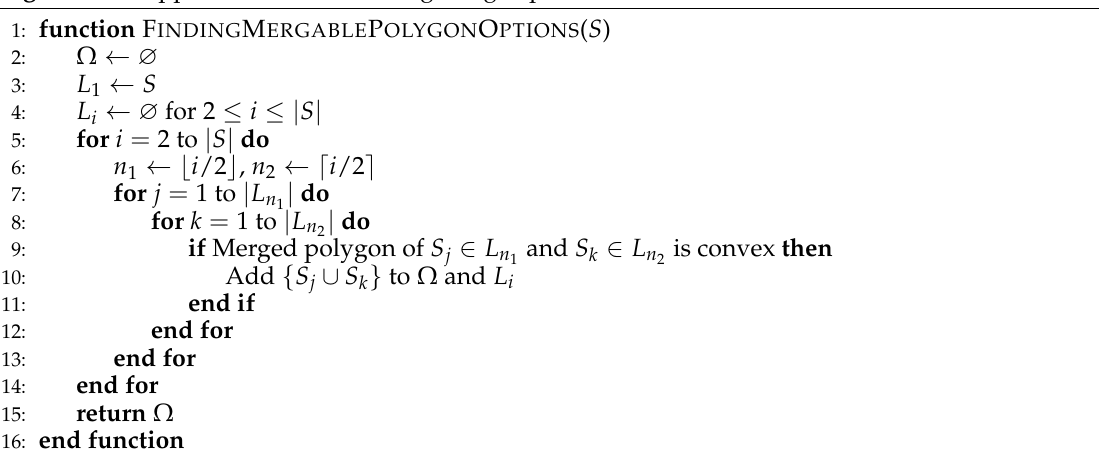
Algorithm 1 Approximation for finding merge